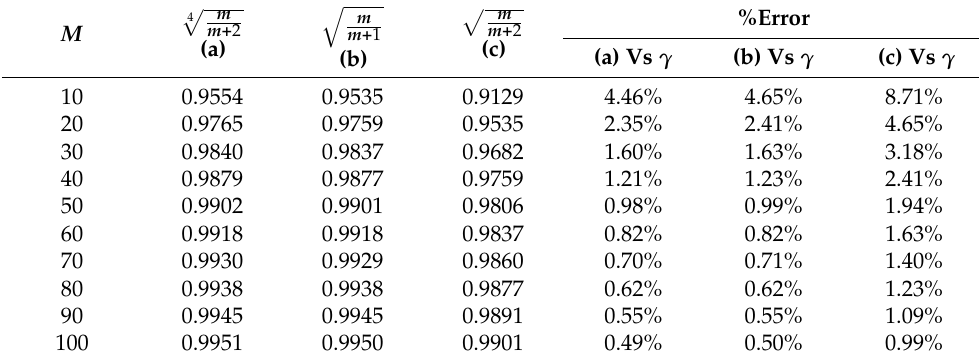
Table 1. Behavior of Expressions (16)–(18) with γ = 1 with different “ m ”